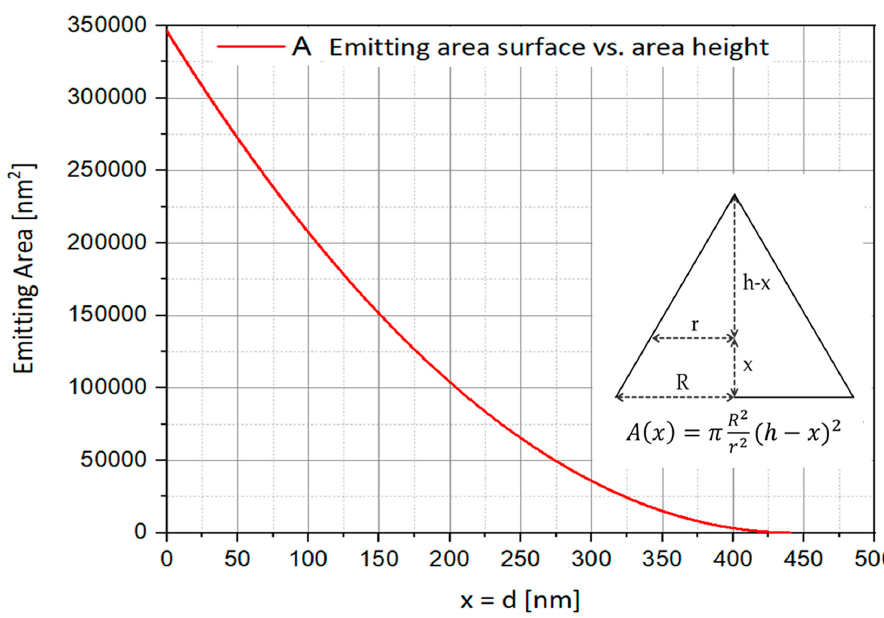
Figure 7. Emitting area surface vs. area height.